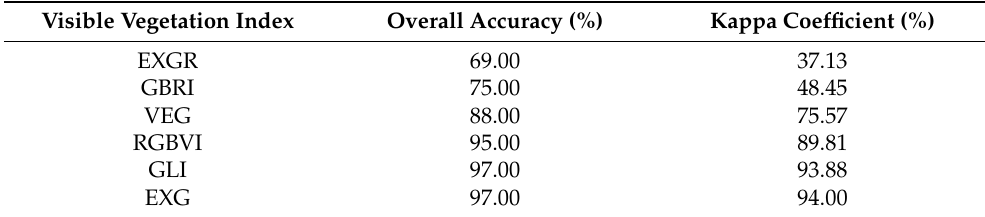
Table 2. The accuracy evaluation of spectral indices